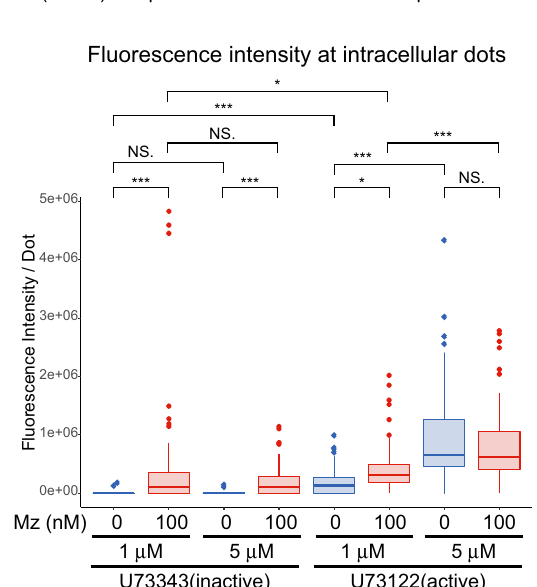
Dwass-Steel-Critchlow-Flinger multiple comparison test with Monte Carlo boxplot indicates the following value: center line, median; box limits, the fi rst and third quartiles; whiskers, 1.5× interquartile range; points above or below the